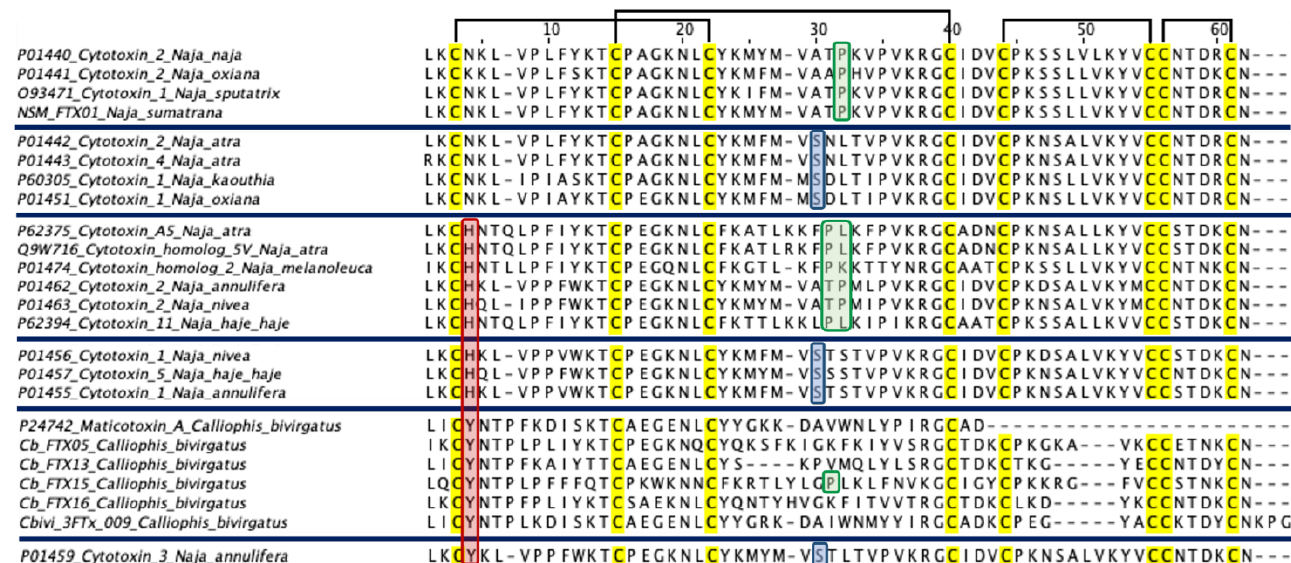
Figure 5. Multiple sequence alignments of cytotoxin-like transcripts of Calliophis bivirgata flaviceps (Cb_FTX05, -13, -15, -16) aligned and compared to closely related sequences from public database. Highlighted in: red box – His-4/Tyr-4-type; blue box – Ser-28-type, green box – Pro-31-type; black brackets – disulfide